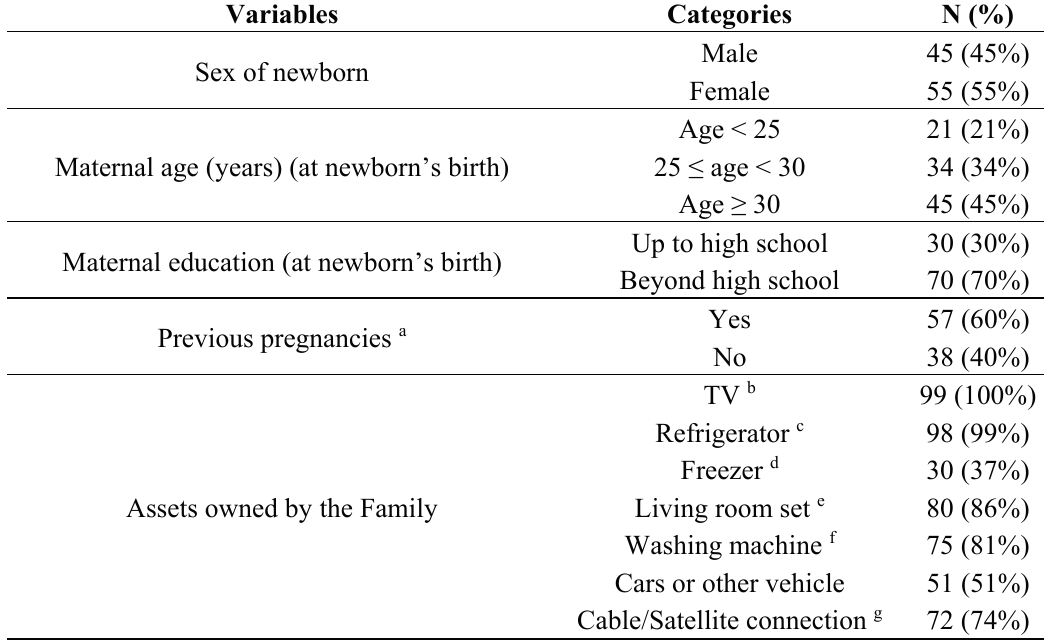
Table 1. Individual and household characteristics of the study